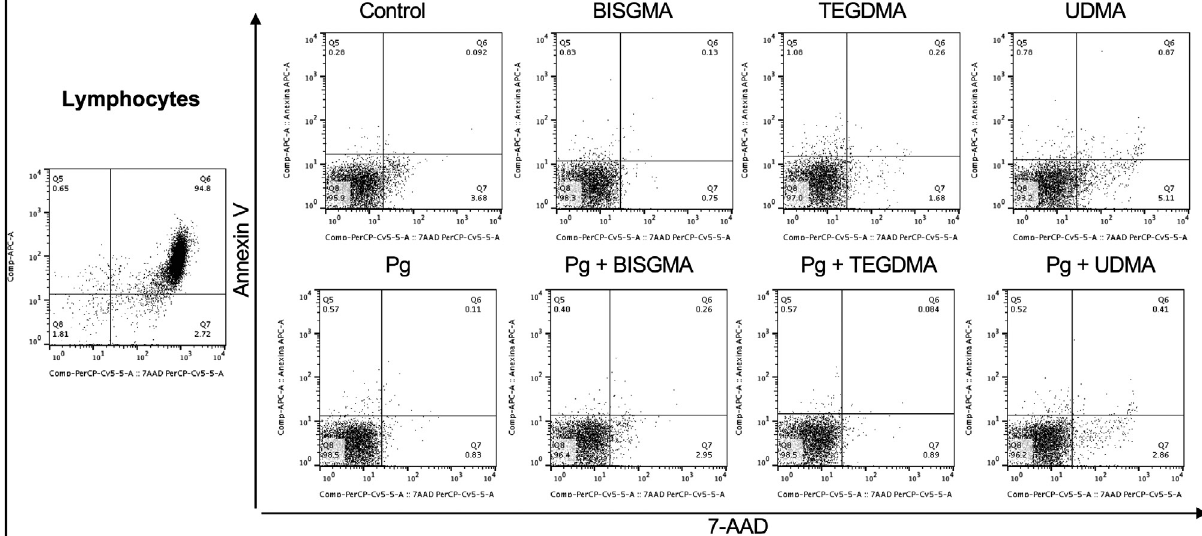
Figure 3- Dot plot graphs representative of Annexin V and 7AAD staining in the lymphocyte population after exposure to resin monomers and P. gingivalis . The dot plot on the left shows the lymphocyte population in the positive control (heat-killed peripheral blood mononuclear